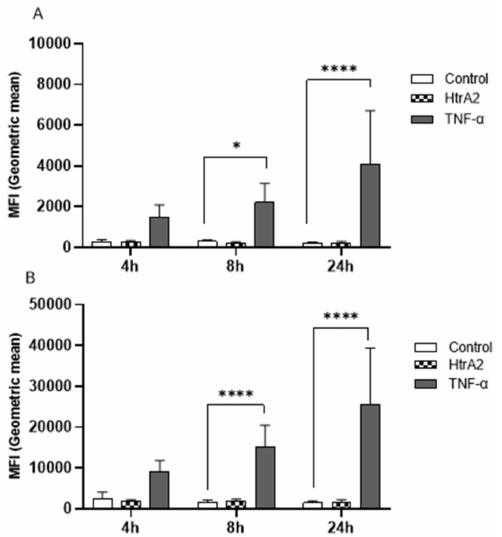
Figure A1. Extracellular HtrA2 did not activate ICAM and VCAM. HUVEC cultures were incubated in HUVEC medium in the presence and absence of TNF α (10 ng), HtrA2 (2 µ g / mL) and HtrA2 + TNF α . The expression of VCAM ( A ) and ICAM ( B ) in HUVECs was determined after 4-, 8- and 24h h by measuring the mean fluorescence intensity (MFI). Results are means with S.D. Significantly di ff erent with **** p < 0.0001 and * p <